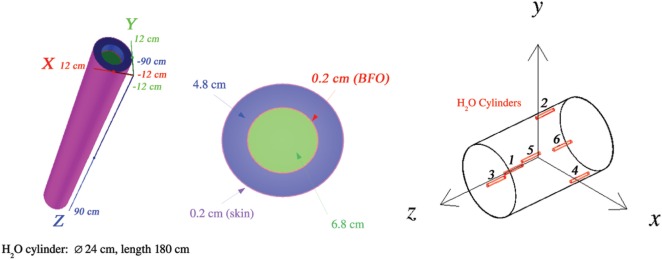
At the left, the cylindrical water volume used to compute the dose of the skin and blood-forming organs (BFO). The body dose refers to the full volume of the 24-cm-diameter, 180-cm-long cylinder (81.4 kg). At the right, the positions of the six water cylinders in the cylindrical habitat.